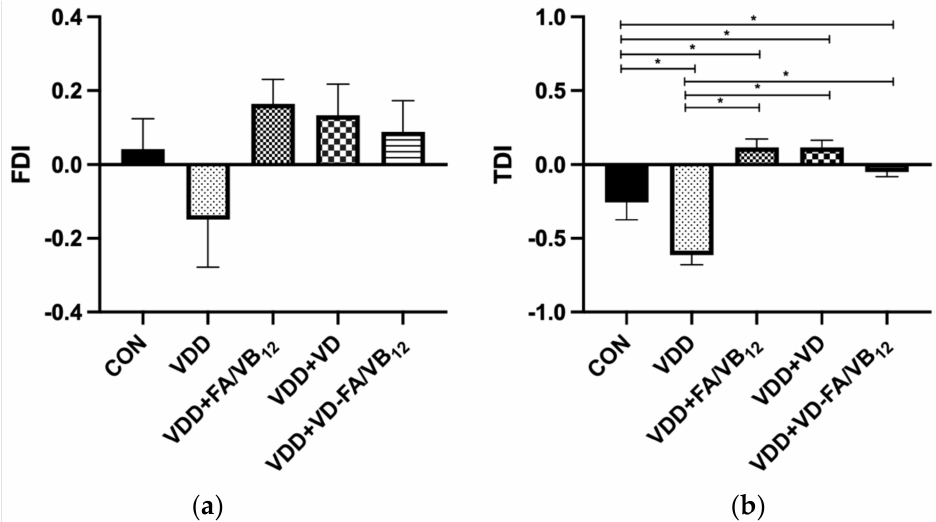
Figure 3. Short-term memory in mice tested by novel object recognition. ( a ) FDI; ( b ) TDI; CON: con- trol; VDD: vitamin D-deficient diet; VDD + FA/VB 12 : vitamin D-deficient diet plus folic acid/vitamin B 12 supplement; VDD + VD: vitamin D-deficient diet plus vitamin D supplement; VDD + VD- FA/VB 12 : vitamin D-deficient diet plus vitamin D and folic acid/vitamin B 12 ; FDI: frequency dis- crimination index; TDI: time discrimination index. All data are presented as the mean ± SEM ( n = 8). A two-sided p < 0.05 was considered statistically